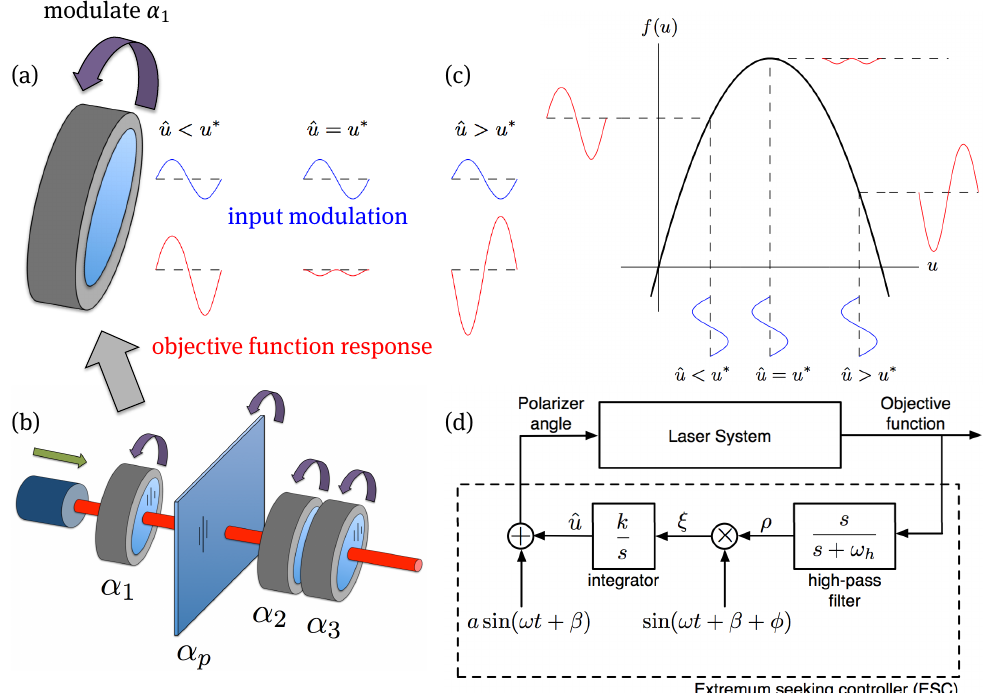
Figure 5: Example of the extremum-seeking control paradigm and associated control diagram. The input parameters α j are modulated ( α 1 in (a)) by servo controllers on (b) all waveplates and the polarizer. The input waveplate angle modulation (in blue) generates a response (in red) of the objective function, giving a method for choosing an updated setting for the polarizer angle. This generates a gradient search towards the extremum as shown in (c). A schematic for single-input, single-output (SISO) ESC is given in